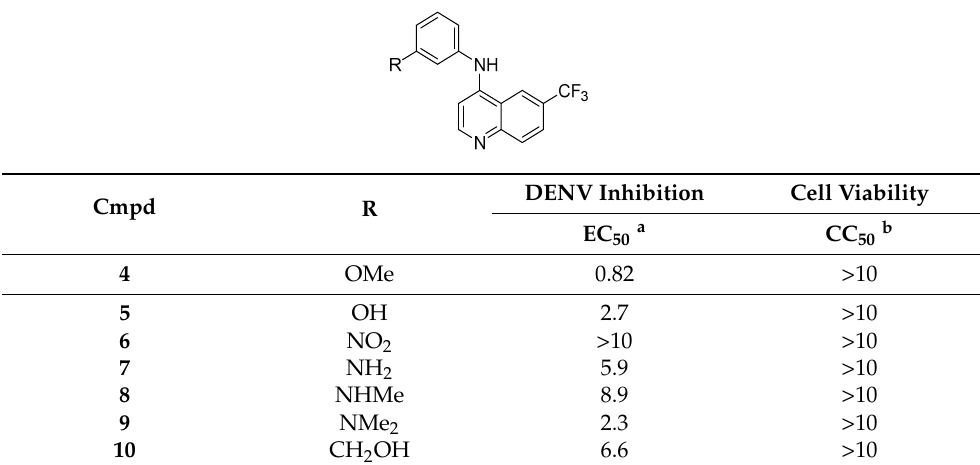
Table 1. Screening results of anti-DENV activity of initial SAR around 3-methoxy aniline substitution pattern of 4.